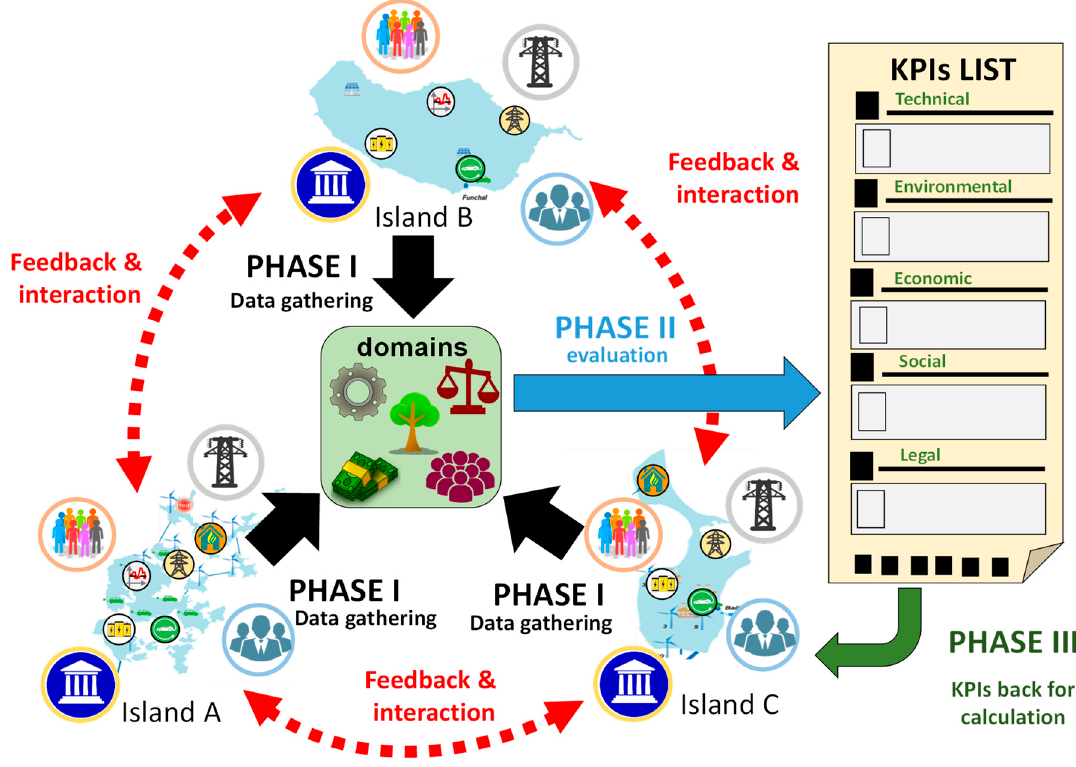
Figure 3. Methodology for gathering, definition and presentation of KPIs.